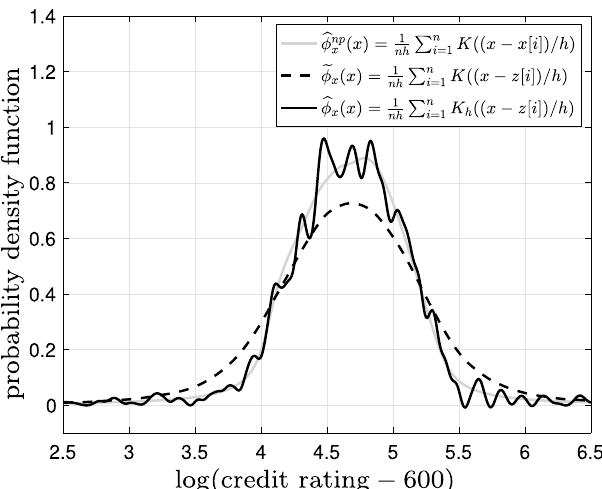
Figure 3. Estimates of probability density function of the credit score using original noiseless data with original kernel